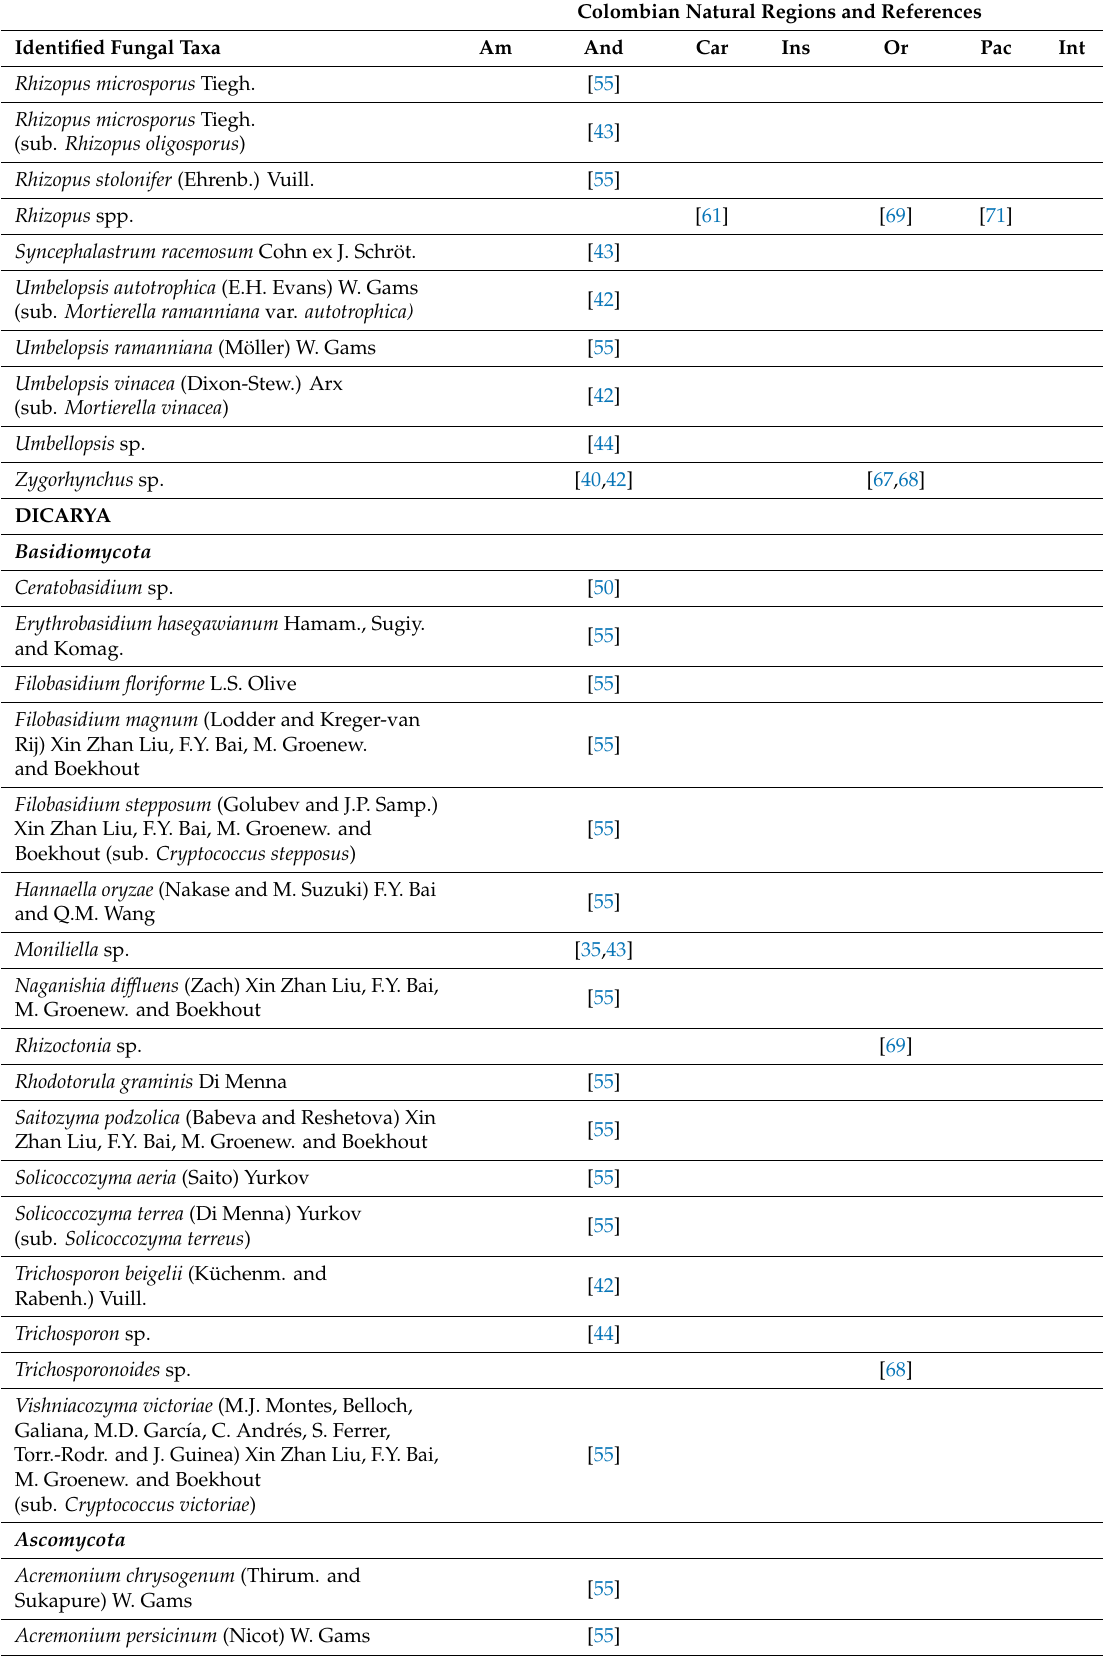
Table 1. Cont . Colombian Natural Regions and